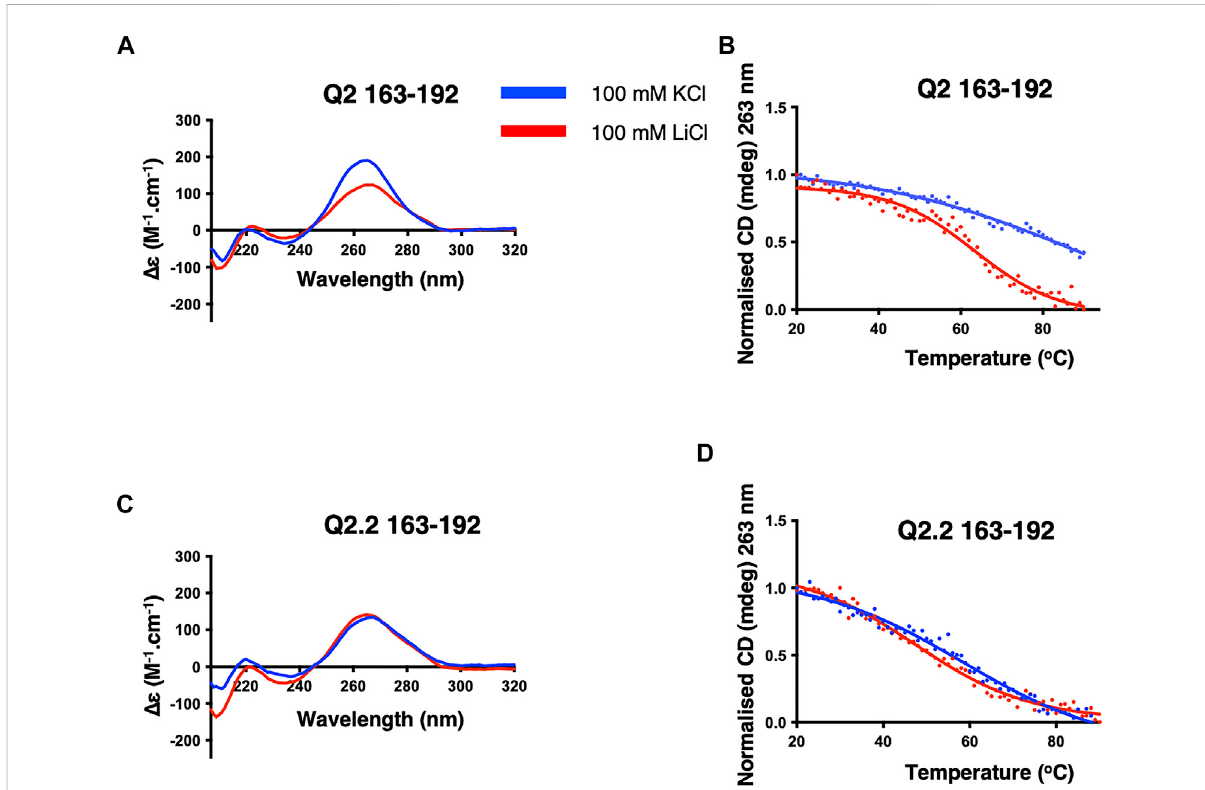
FIGURE 3 CDspectraandthermalmeltsoftheQ2andQ2.2163 – 192Bcl-xfragments.CDat20 ° CandthermalmeltingcurvesinthepresenceofKCl(blue) and LiCl (red) of Q2 163 – 192 (A,B) and Q2.2 163 – 192 (C,D) . All experiments were conducted with 2 µM RNAs in 10 mM TBA phosphate buffer pH 7.0 with 100 mM salt in a 1 cm pathlength quartz